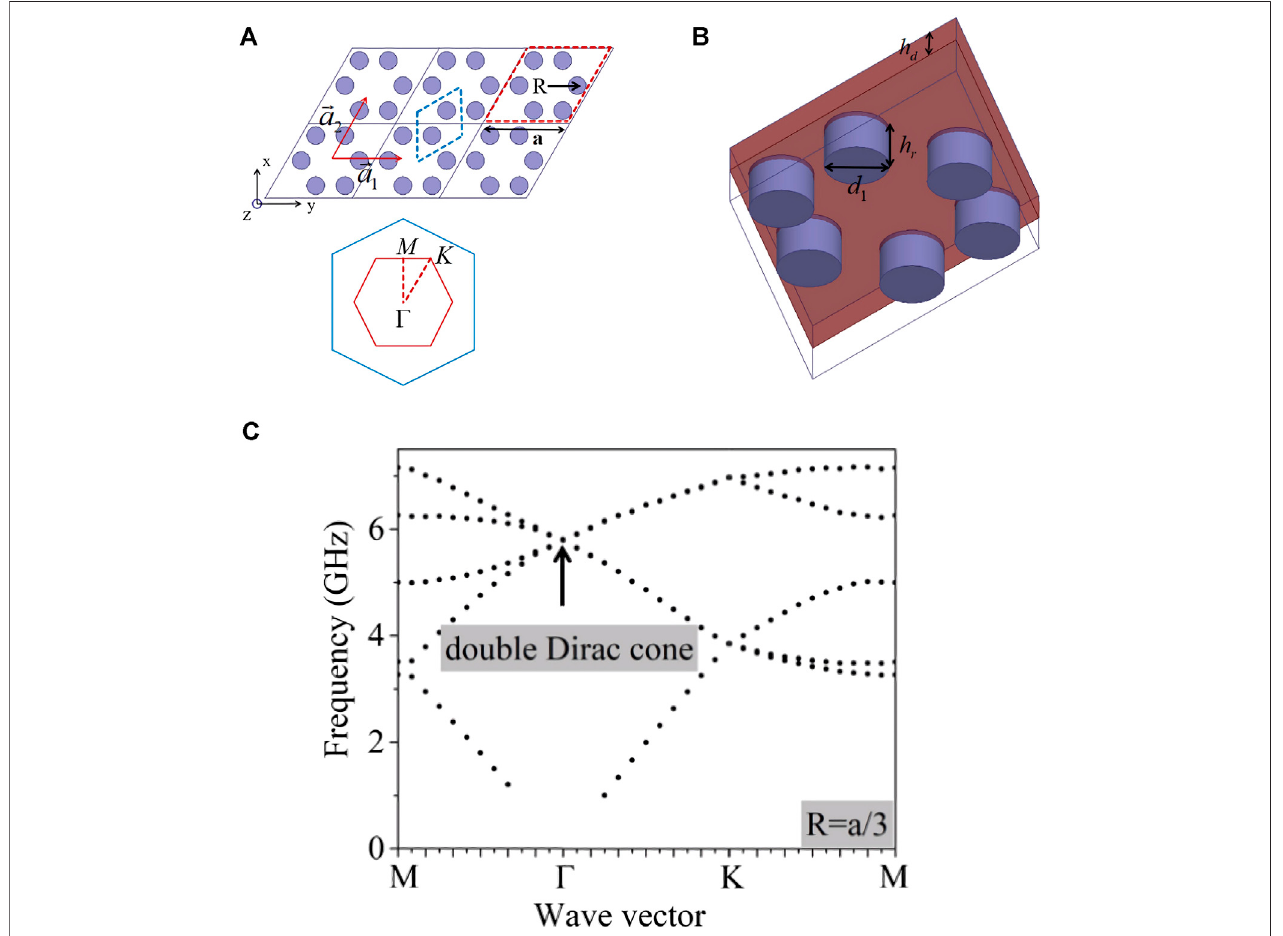
→ → 1 and a 2 are lattice vectors